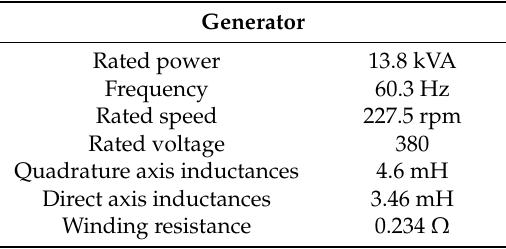
Table 3. Parameters of the PMSG for experiment.